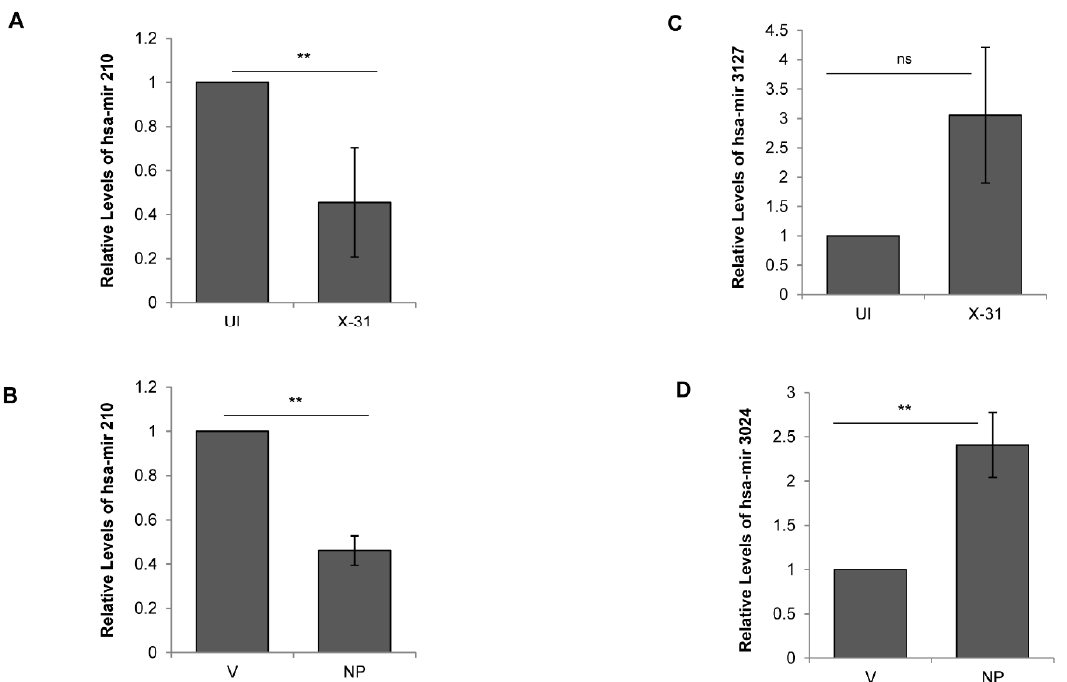
Figure 5. Regulation of cellular miRNAs during IAV infection. ( A , C ) A549 cells were infected with X-31 at an MOI of 1 and samples were collected at 48 hpi. Total RNA was isolated for quantitating miR-210 and miR-3127 transcript levels using stem-loop qPCR primers. ( B , D ) A549 cells were transfected with V or with NP for 72 h. Total RNA was isolated for the assessment of the level of miR-210 and miR-3024 transcripts by qPCR using specific primers. The data above is shown as mean ± S.D. of three independent experiments. * and ** indicate statistically significant differences at p <0.05 and p < 0.01, respectively. ns denotes non-significant.